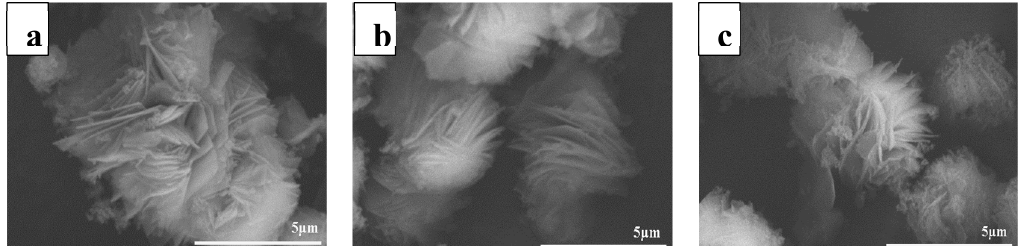
Figure 2. SEM images of ( a ) MAG; ( b ) MAG–CTAB and ( c ) MAG–CTAB–KH550.